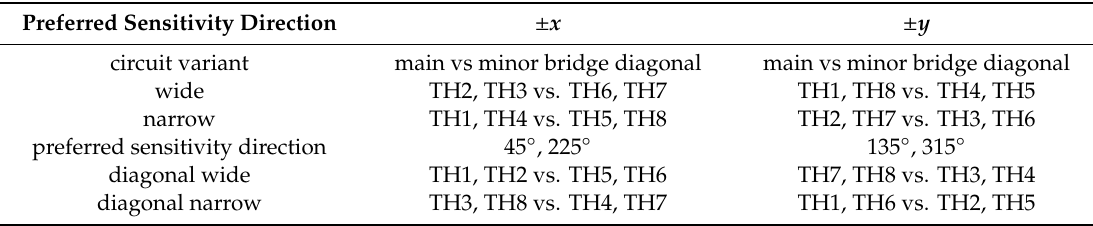
Table 2. Distinct configurations of double resistance